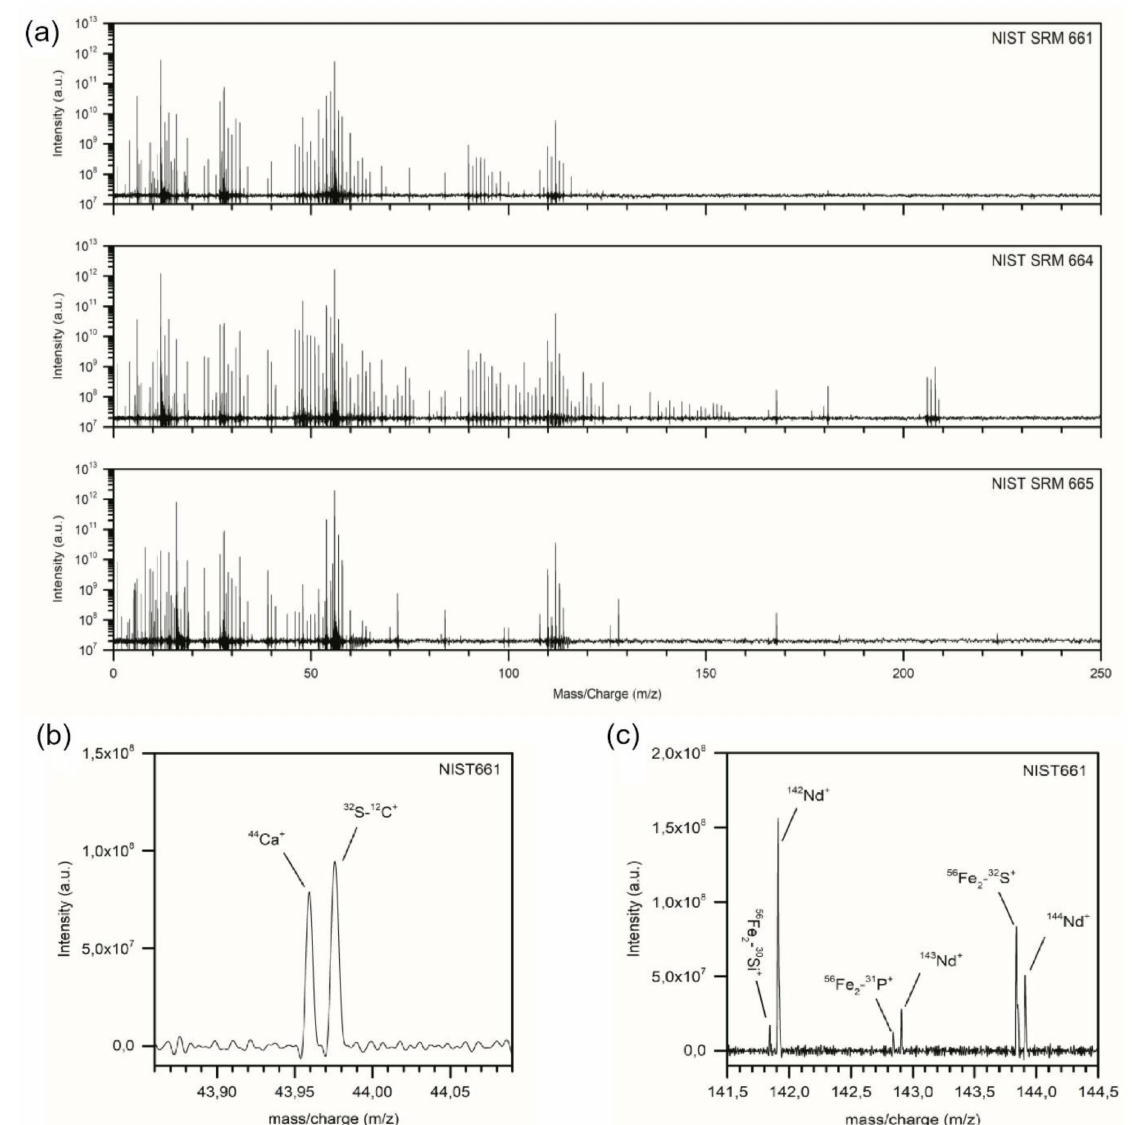
Figure 7. ( a ) Typical spectrum recorded with LMS-GT for three NIST SRM steel samples. The applied mass range is compatible with the applied data acquisition card to optimally use the sampling range of the card; ( b ) At the mass m/z = 44 both isotopic 44 Ca and diatomic 32 S- 12 C mass peaks can be measured; ( c ) At the mass peaks 142, 143 and 144 in addition to isotopic Nd also diatomic mass peaks are observed